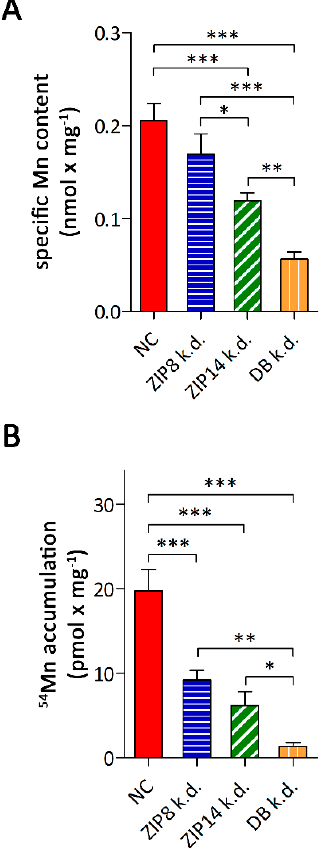
Figure 5. Consequences of RNAi-mediated knockdown of ZIP8 and / or ZIP14 on Mn metabolism of A549 cells. ( A ) specific Mn contents and ( B ) 54 Mn accumulation. Data are presented as means ± SD from three independent experiments performed in duplicates. Statistical analysis was performed using one-way ANOVA followed by the Bonferroni post-hoc test with * p < 0.05, ** p < 0.01, and *** p < 0.001.